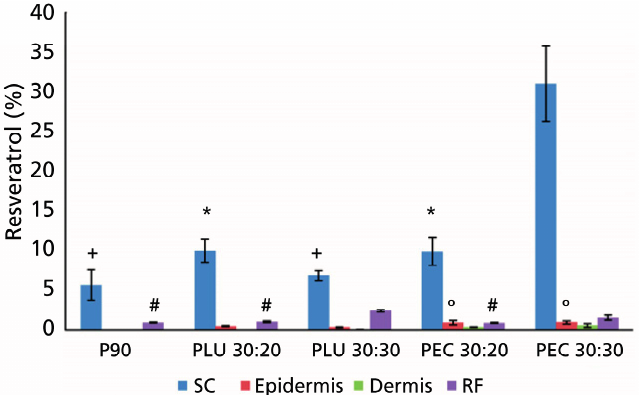
Figure 2. Percentage of resveratrol accumulated in stratum corneum (SC), epidermis, dermis, and receptor fluid (RF) applied onto the skin into P90-liposomes and PLU- or PEC-niosomes. Each value is the mean ± SD of six experimental determinations. No statistical differences ( P > 0.05) were found in samples labelled with the same symbol (*, +, #, °). Reproduced with permission from [26], published by Royal Pharmaceutical Society,